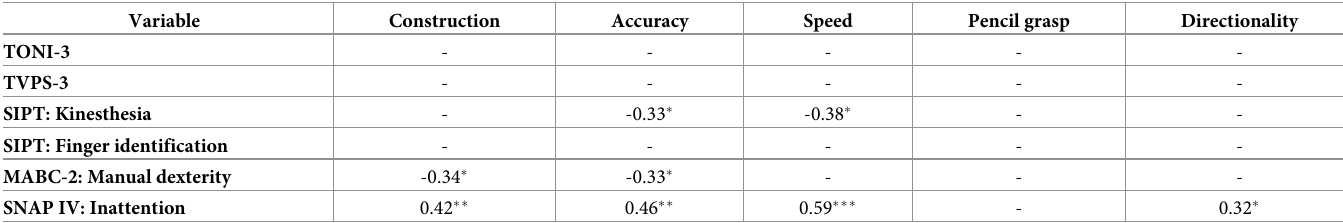
Table 4. Correlates with handwriting performance in preterm subgroup (n =